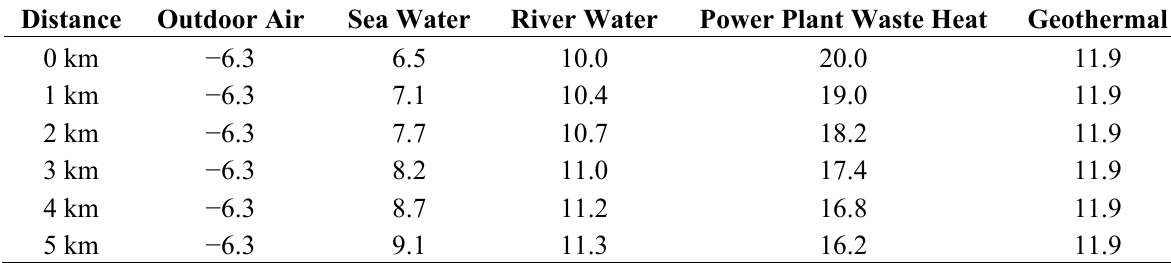
Table 5. Average outlet temperature on the representative day of each heat source according to distance